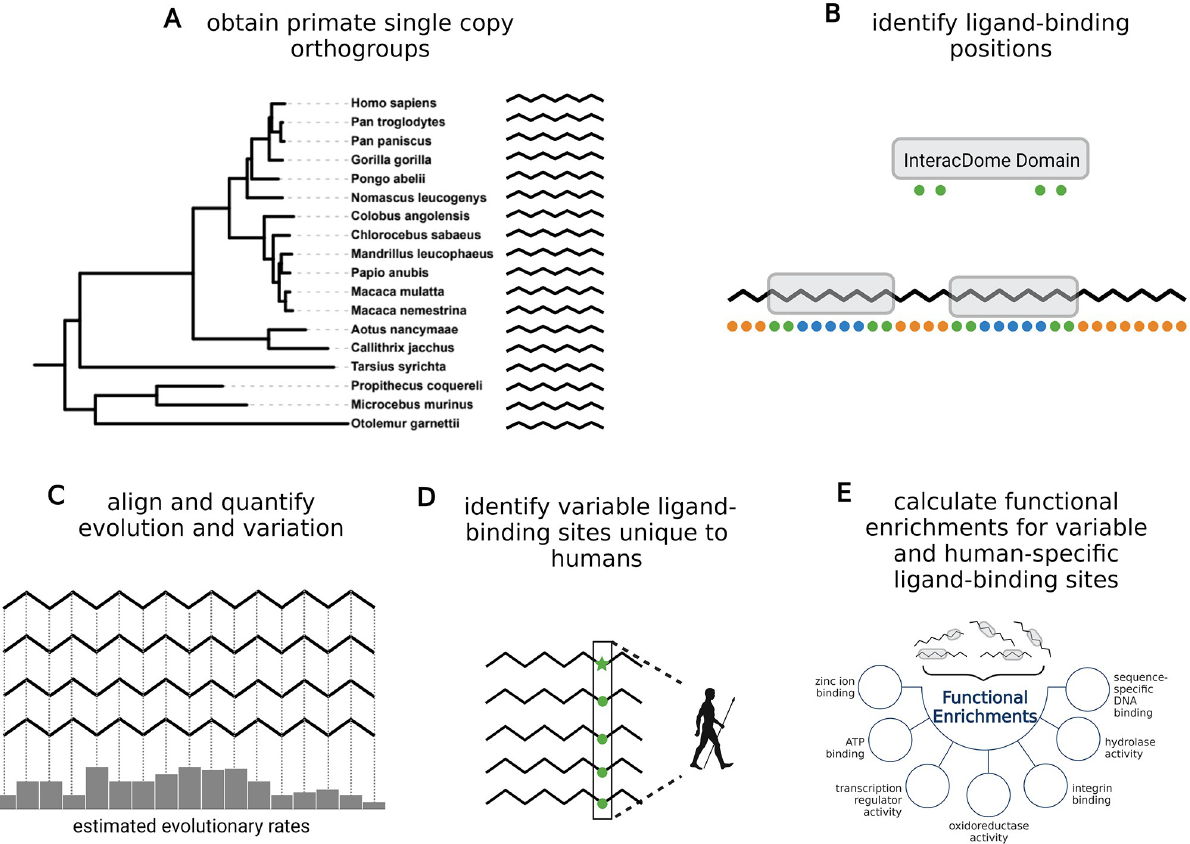
Fig 1. Overview of pipeline for characterizing ligand-binding site evolution in primates. (A) Single-copy orthogroups from 18 primate species were obtained from OrthoDB [61]. The phylogenetic tree of the 18 primate species considered is shown, and includes six apes, eight monkeys, and four prosimians; the tree is extracted from a molecular phylogeny of 186 extant primates [64] and visualized using the iTOL platform [65]. (B) For each orthogroup, domain-level site-wise ligand-binding data from the InteracDome [58] was transferred from domain space to the primary sequence space across sequences within each orthogroup. Green dots under the domain specify the ligand-binding positions within the domain. Grey boxes show instances of InteracDome domains within a sequence. Within that sequence, green depicts residues annotated as ‘ligand-binding sites,’ blue depicts residues within domains that are annotated as not ligand-binding sites and are annotated as ‘other sites within domains,’ and orange depicts residues outside of domains. The ‘other sites’ group is comprised of sites depicted by blue and orange. Only orthogroups that contain at least one InteracDome domain were analyzed. (C) Orthogroups were filtered and aligned to build a final set of high confidence alignments (see Materials and methods), from which per-site evolutionary rates and variation were computed. To assess whether sites binding different types of ligands are under varying evolutionary pressure, evolutionary rates and variation of sites of different ligand-binding types were compared. (D) Human-specific variation—consisting of sites where a single amino acid is found across all primates (green circle) and an alternate amino acid is found in human (green star)—within ligand-binding sites was identified. (E) To assess whether human genes that exhibit human-specific variation in their ligand-binding sites tend to be associated with specific biological processes, functional enrichments were computed for these genes as compared to all other human genes in our ligand-binding dataset; we repeated this process for all sequences containing variable ligand-binding interfaces. Created with